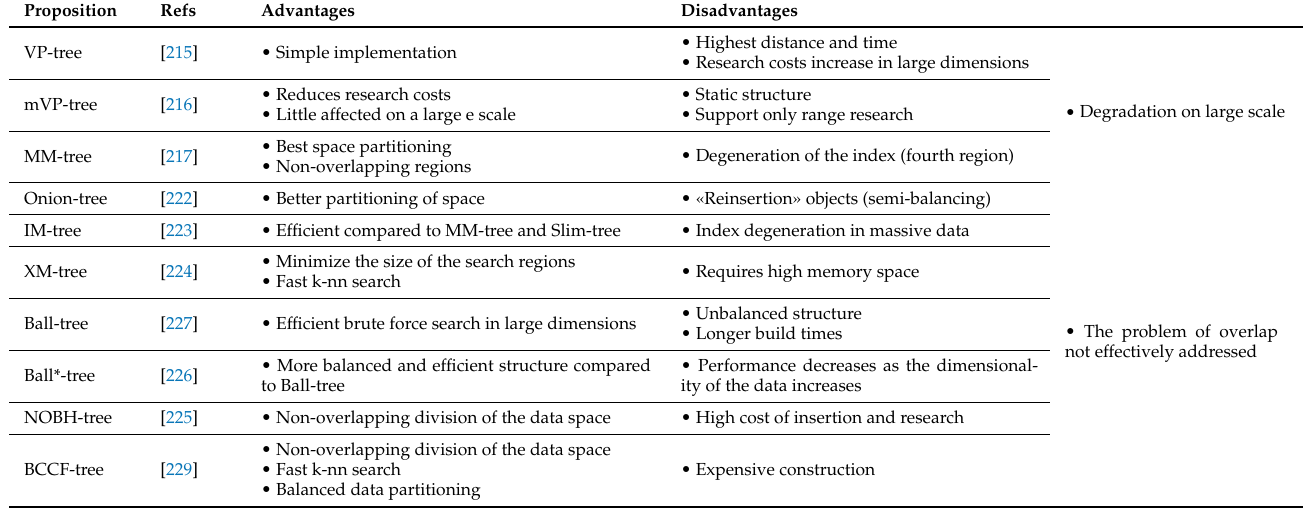
Table 12. Summary of advantage and disadvantage of metric indexing techniques based on ball